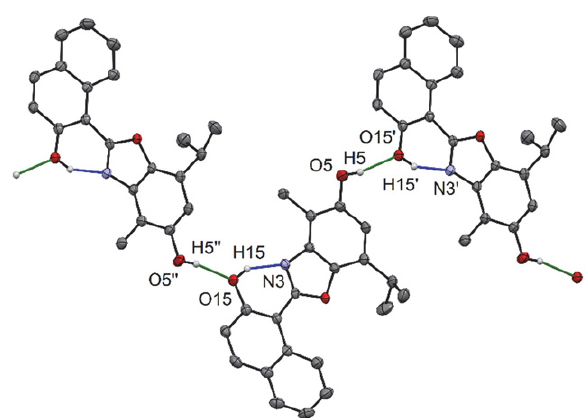
Figure 3. Hydrogen bond network in the crystal structure of 2. The hydroxyl group in position 5 forms intermolecular hydrogen bonds (green) with the O15 oxygen on the naphthyl group (O5–H5···O15’) which in turn forms an intramolecular hydrogen bond (blue) with the neighboring benzoxazole N3 nitrogen atom (O15–H15 Thermal ellipsoids are drawn at 50% probability level and non-rele- vant hydrogen atoms are omitted.